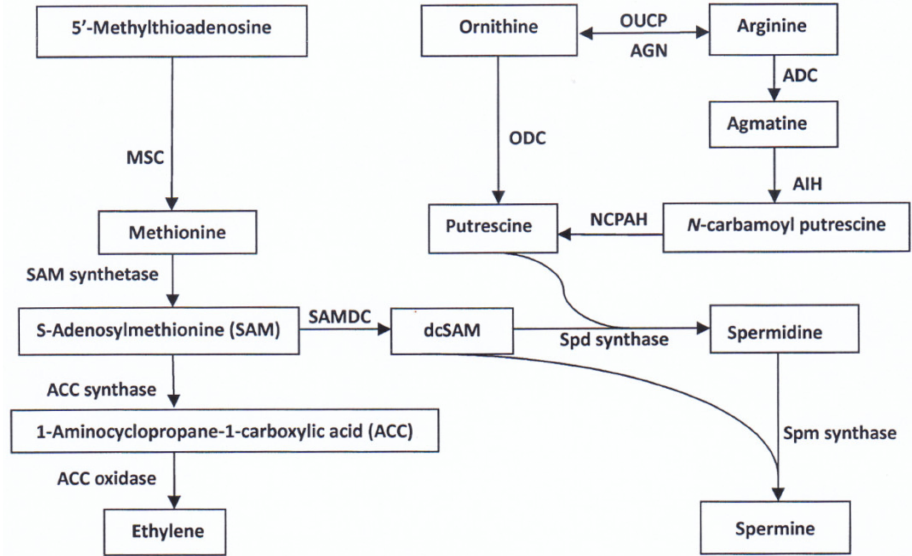
Figure 3. Principal pathways of polyamine and ethylene biosynthesis in plants. OUCP,